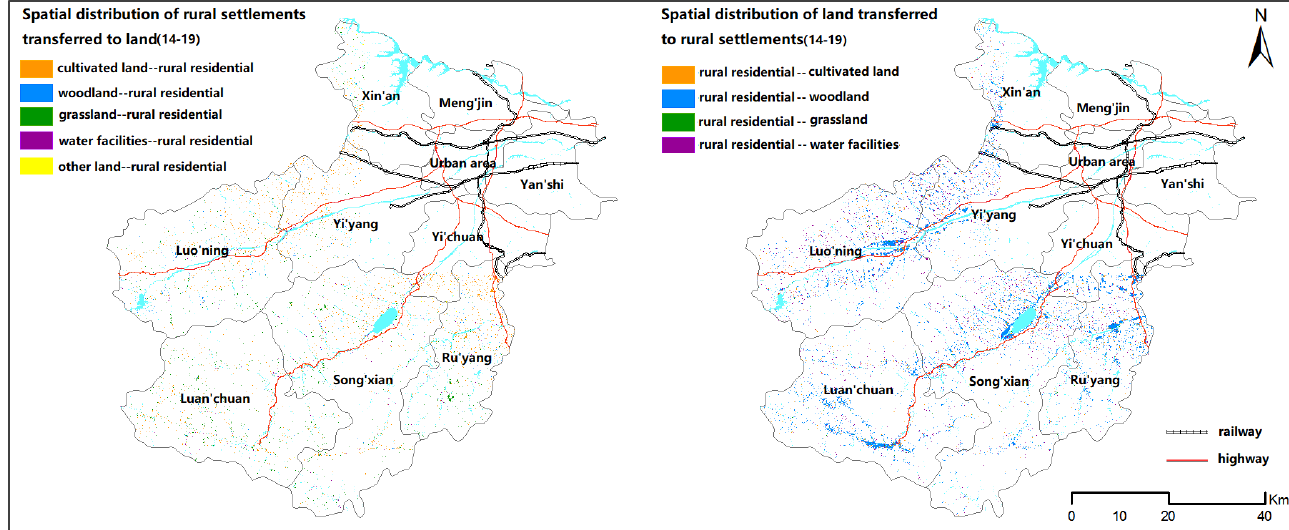
Figure 6. Spatial Distribution of Land Types Transferred to and from Rural residentials in Luoyang region (2014 – 2019).